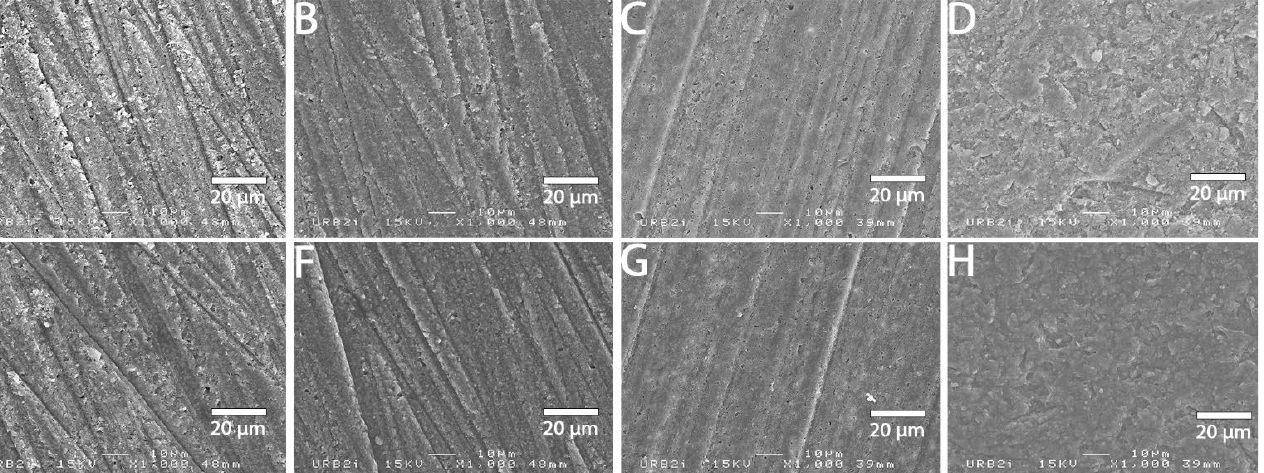
Figure 2. SEM micrograph for Cerasmart 270 surface (×1000 magnification) with the different sur- face treatments: ( A ) control; ( B ) polyacrylic acid; ( C ) hydrofluoric acid; ( D ) sandblasting; ( E ) 800 grit polishing + universal primer; ( F ) polyacrylic acid + universal primer; ( G ) hydrofluoric acid + uni- versal primer; ( H ) sandblasting + universal primer. Sandblasting surface treatment ( D , H ) shows a more irregular pattern surface than the others ones.